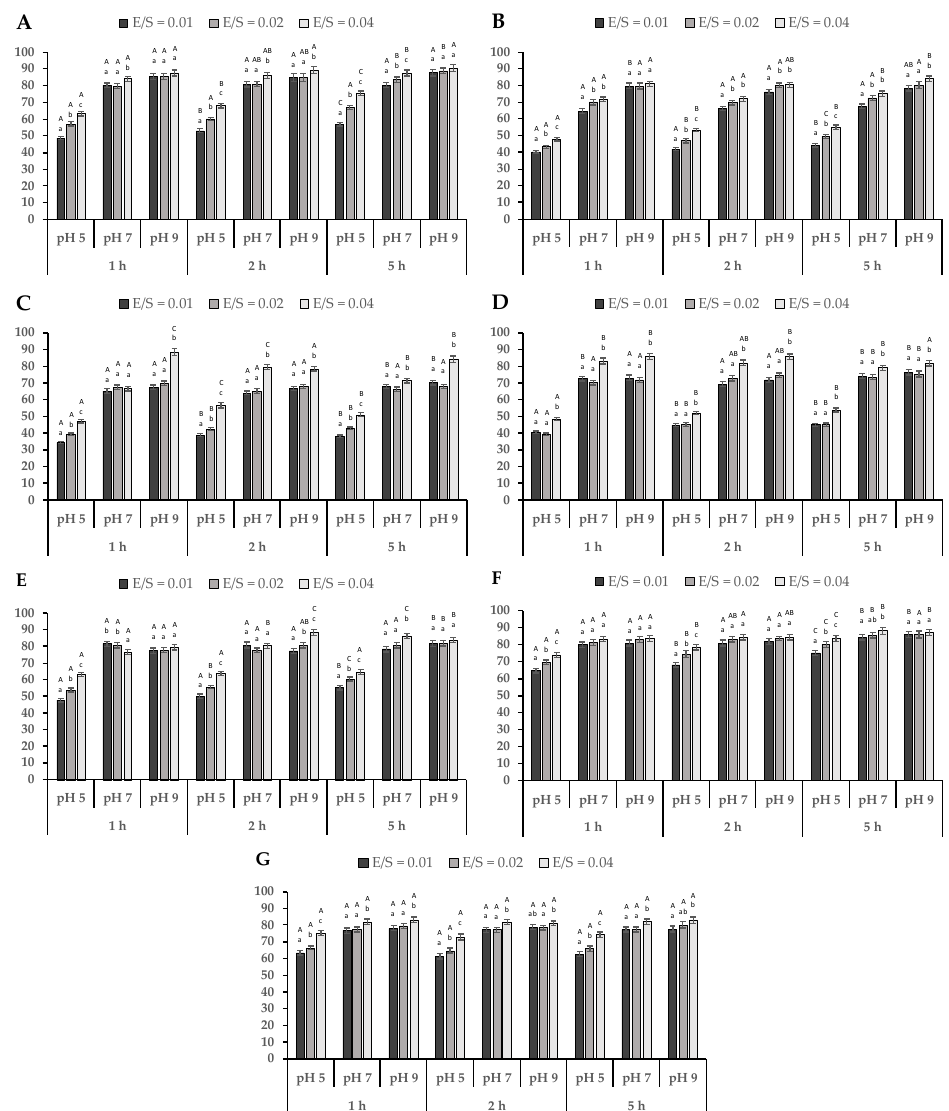
Figure 3. Protein solubility of the hydrolyzed lupin protein isolate (LPI) samples at different E/S (enzyme/substrate) ratios and hydrolysis times by different commercial proteases measured at different pHs. ( A ) Acid Stable Protease, ( B ) Fungal Protease A, ( C ) Opti-Ziome TM P 3 Hydrolyzer TM , ( D ) Neutral Protease, ( E ) Protamex ® , ( F ) Alcaline Protease L, and ( G ) Alcalase ® 2.4 L FG. Means with different capital letters in the same row indicate significant differences in each hydrolysis time ( p < 0.05). Means with different lowercase letters in the same column indicate significant differences in each E/S ratio ( p <